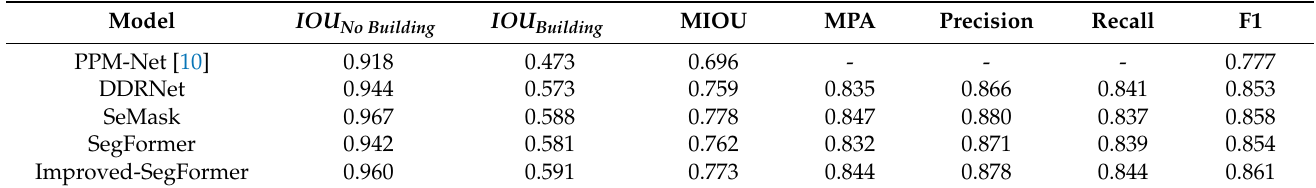
Table 4. The data categories were combined to obtain the relevant evaluation indexes for both No Building and Building categories.